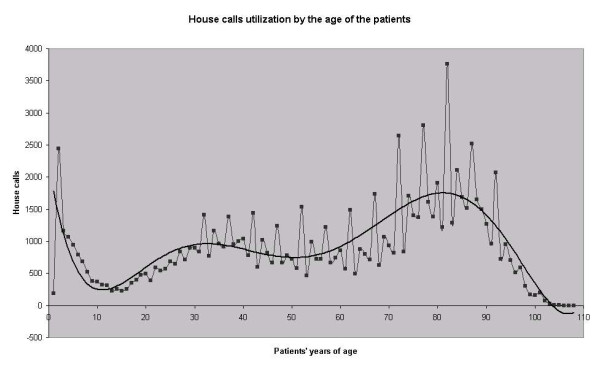
House calls utilization by the age of the patients.